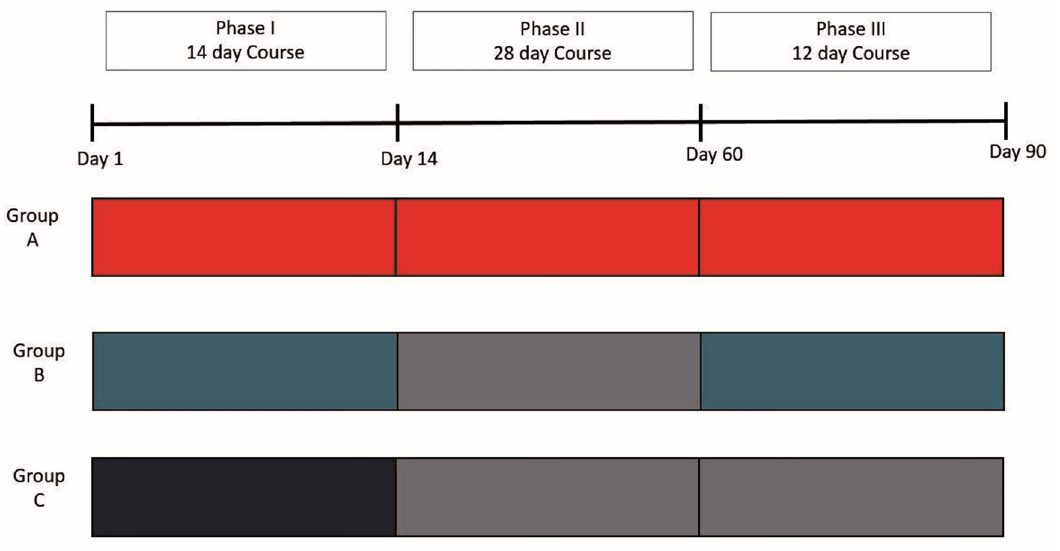
Figure 1. Study design.